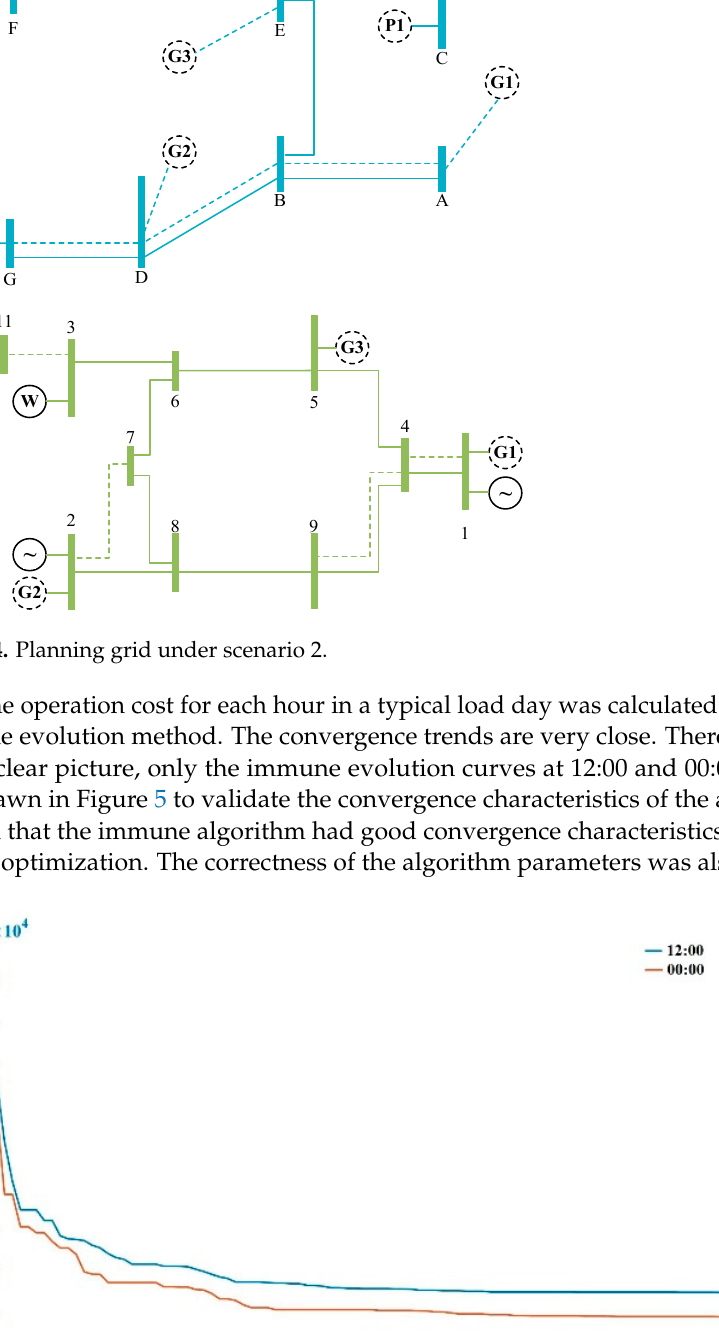
Figure 3. Planning grid under scenario 1.